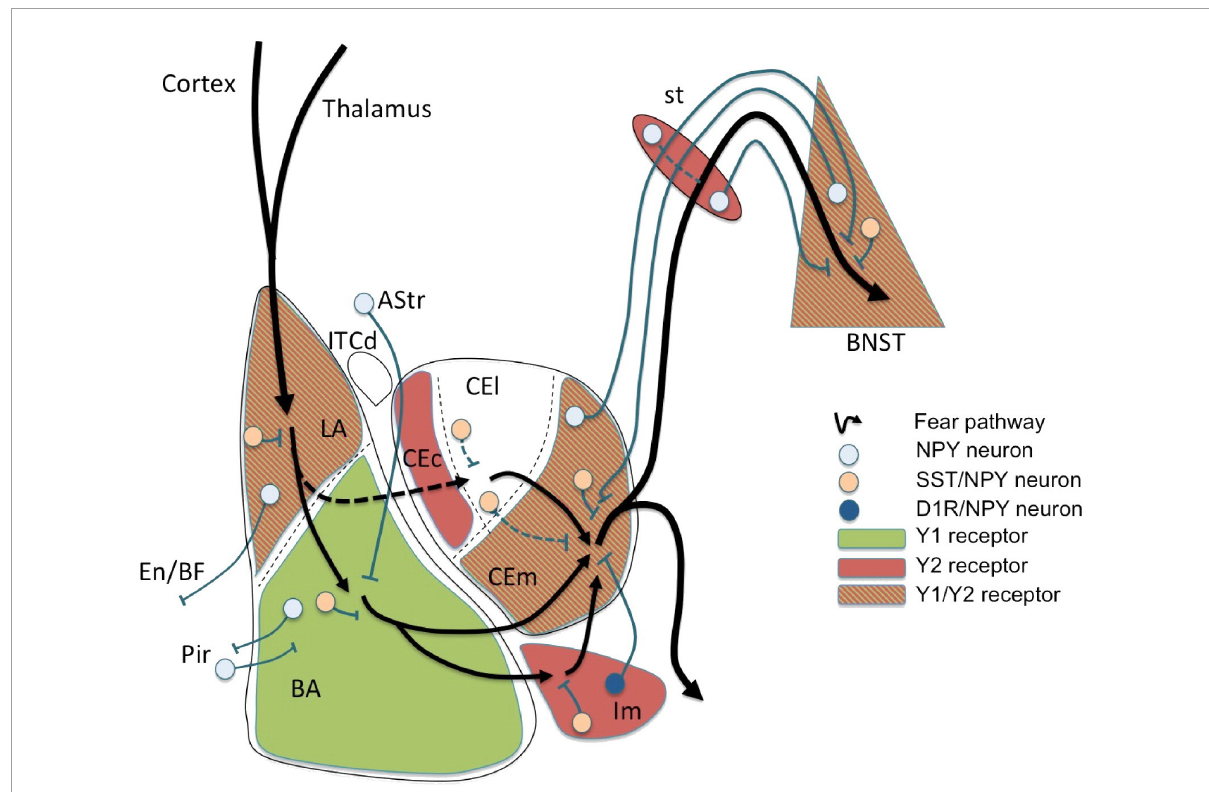
FIGURE1 Fear circuit in the amygdala. Cortical and thalamic projections conveying somatosensory (US) and auditory (CS) information are targeting the lateral amygdala (LA), a major location of initial synaptic plasticity. Somatostatin (SST)/neuropeptide Y (NPY)/ γ -aminobutyric acid (GABA) neurons may inhibit pyramidal neurons by activation of postsynaptic Y1 and presynaptic Y2 receptors reducing CS-related activation and fear learning. Similarly, SST/NPY neurons in the basolateral nucleus (BLA) may have additional Y1 receptor-dependent inhibiting effects. The role of NPYergic afferent and efferent projections of the basolateral complex (LA and BLA) is not yet clear. Fear related stimuli reach the central amygdala (CEA) also via mediodorsal intercalated neurons (ITCd) to the centrolateral subdivision (CEl) or directly via projections from the BLA to the centromedial subdivision (CEm). NPY neurons may modulate afferent and efferent signals locally in the CEl or via inhibitory connections between CEl and CEm, probably by Y2 receptors. However, the main processing occurs in the CEm (expressing Y1 and Y2 receptors) by (1) local inhibitory SST/NPY/GABA neurons, (2) by NPY/GABA afferents originating from the BNST, and (3) by NPY axon terminals originating from neurons of the main intercalated nucleus (Im). The latter projection consisting of NPY/dopamine receptor D1 (D1R)/GABA neurons in the Im